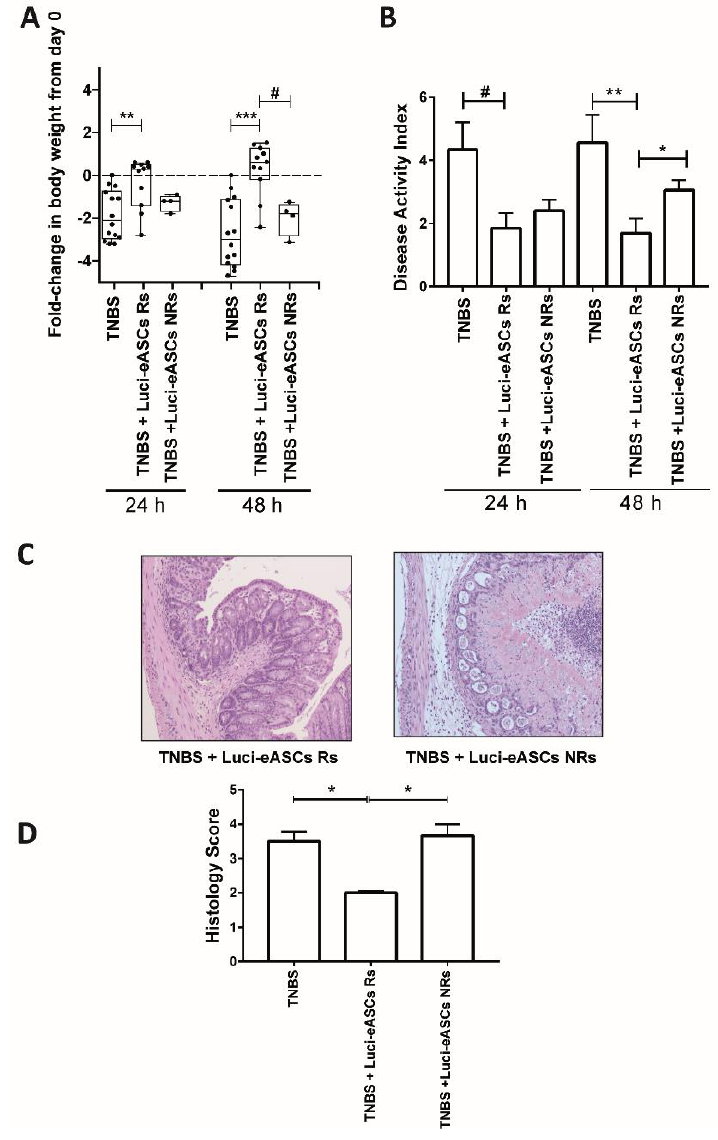
Figure 4. Stratification of in vivo responses to treatment with Luci-eASCs administered IP in TNBS-colitic mice according to the fold-change in body weights and disease activity index, from 24 h to 48 h, and histological analysis at 48 h. Colitic mice treated with Luci-eASCs were grouped into “responders” (Rs mice that did not lose weight at 48 h with respect to 24 h) and “non-responders” (NRs mice that lost weight at 48 h with respect to 24 h). ( A ) Fold-change in body weights at 24 h and at 48 h. TNBS, n = 14; TNBS + Luci-eASCs Rs, n = 9 and TNBS + Luci-eASCs NRs, n = 6. Data are presented by dots and box-plots that represent the interquartile range (p75, upper edge; p25, lower edge; p50, midline; p95, line above the box, and p5, line below the box) in fold-change in body weights. ( B ) Disease activity index at 24 h and 48 h of TNBS ( n = 9), TNBS + Luci-eASCs Rs ( n = 13) and TNBS + Luci-eASCs NRs ( n = 10) mice. Data are presented by mean and standard error of the mean of disease activity index at 24 h and 48 h. ( C ) Representative images of colon tissue (10×) at 48 h of TNBS, TNBS + Luci-eASCs Rs and TNBS + Luci-eASCs NRs. ( D ) Histology score of TNBS ( n = 14), TNBS + Luci-eASCs Rs ( n = 4) and TNBS + Luci-eASCs NRs ( n = 3). Data are presented by mean and standard error of the mean of histology score at 48 h. Significance was analyzed by the Mann-Whitney U test and represented by # p ≤ 0.025, * p < 0.05, ** p < 0.01 and *** p < 0.001. Results correspond to four independent experiments.